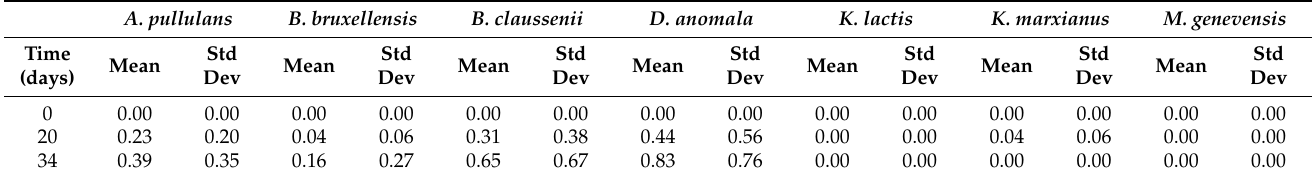
Table 8. Tartaric acid concentrations under aerobic fermentation (g/L).